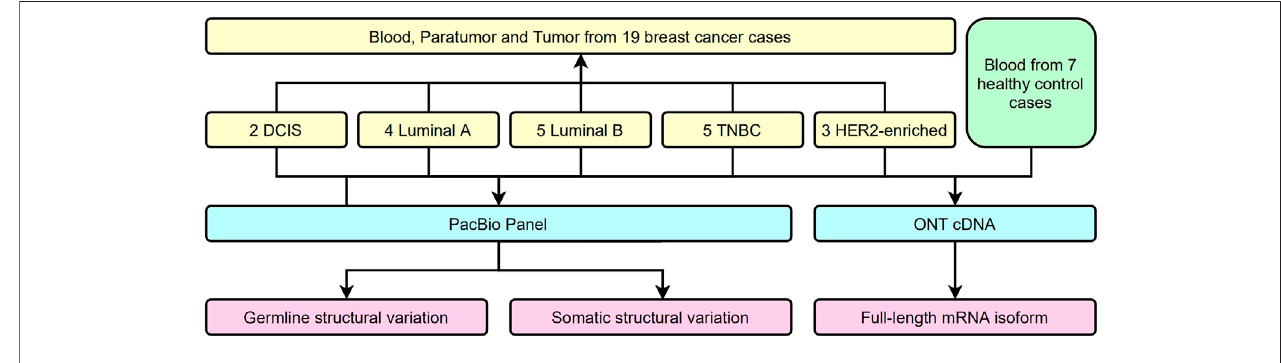
FIGURE 1 | Flow chart of study design.